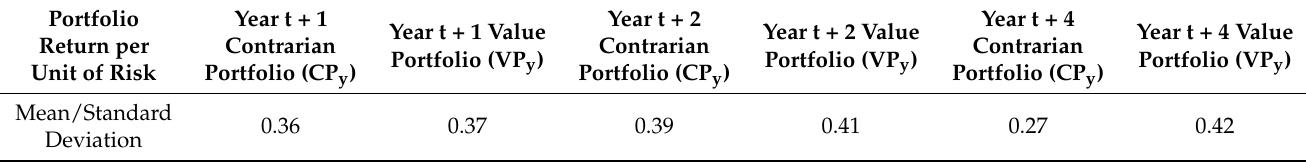
Table 10. Portfolio return per unit of